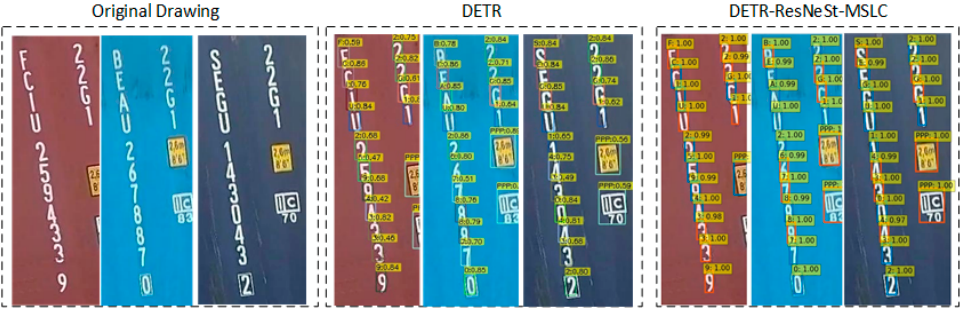
Figure 6. The detection results of the two models respectively on the characters.